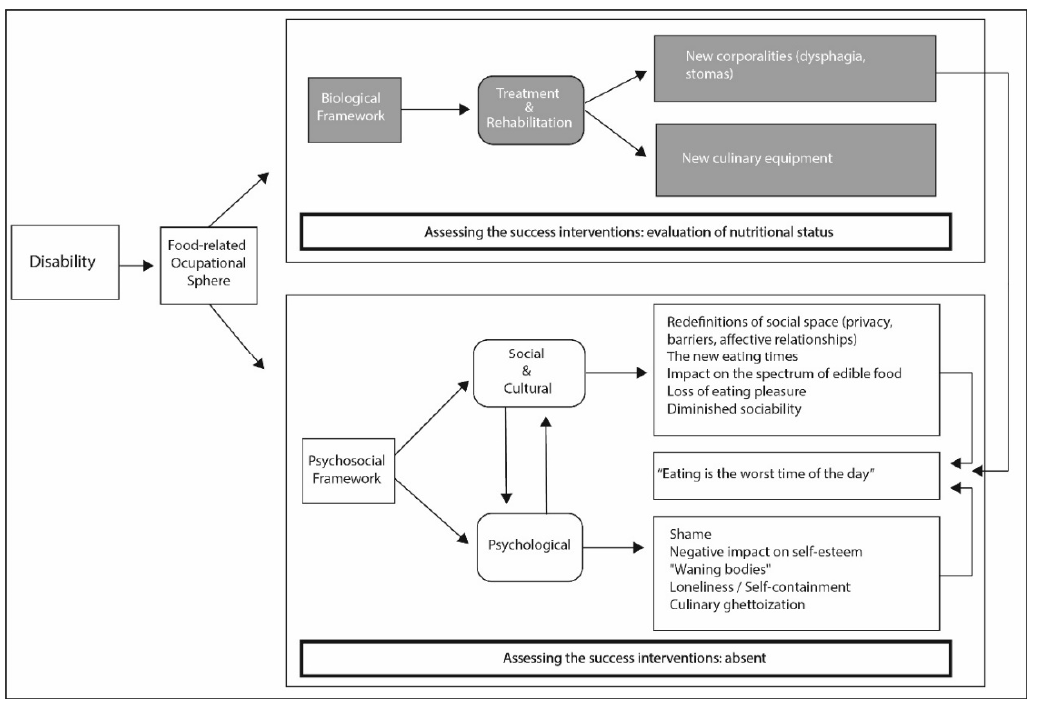
Figure 1. Impact of disability on the occupational sphere. Therapeutic concerns are highlighted in shadowed areas.